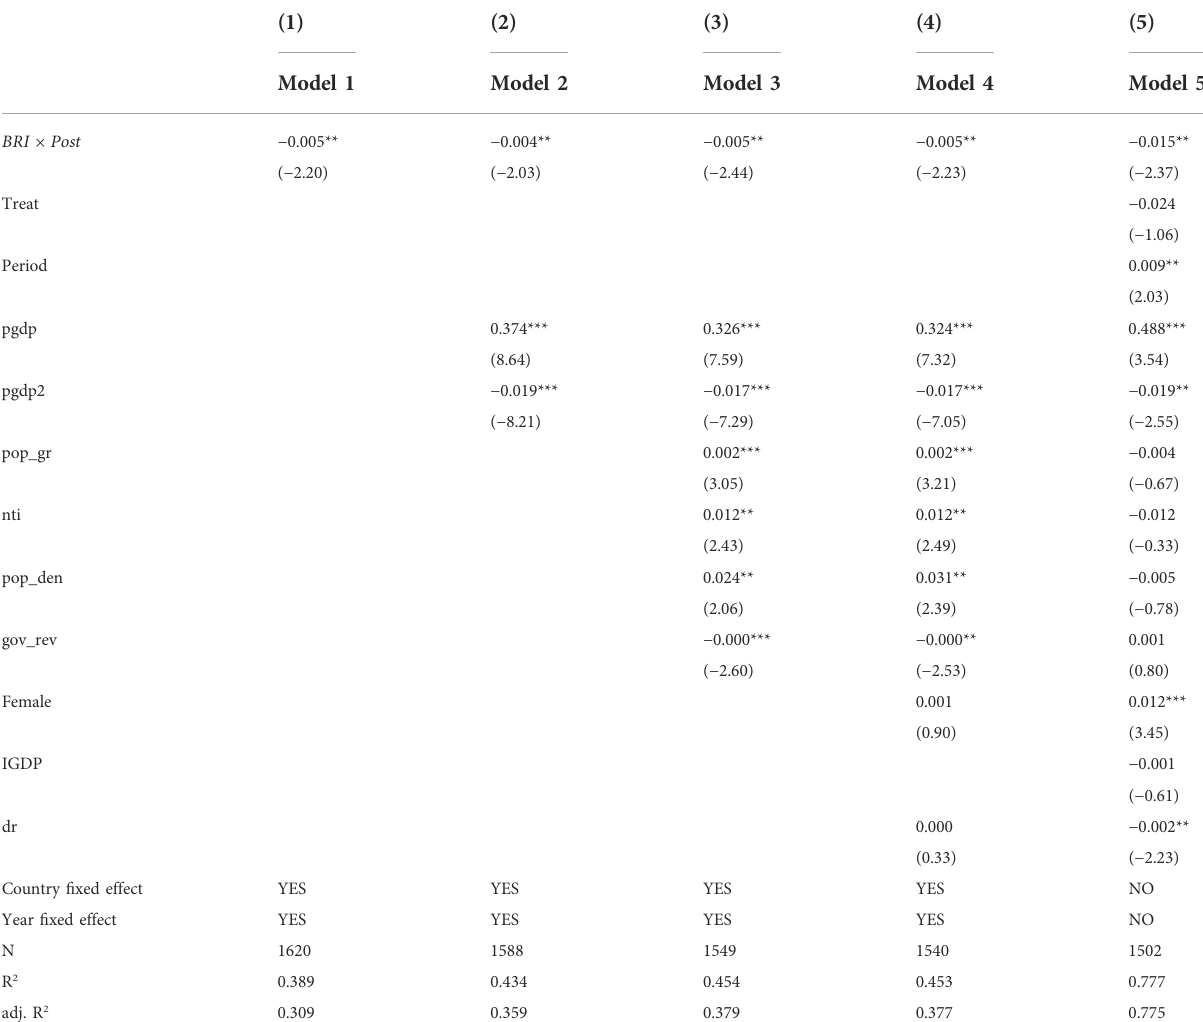
TABLE 2 Effects of the Belt and Road Initiative on environmental quality: Baseline